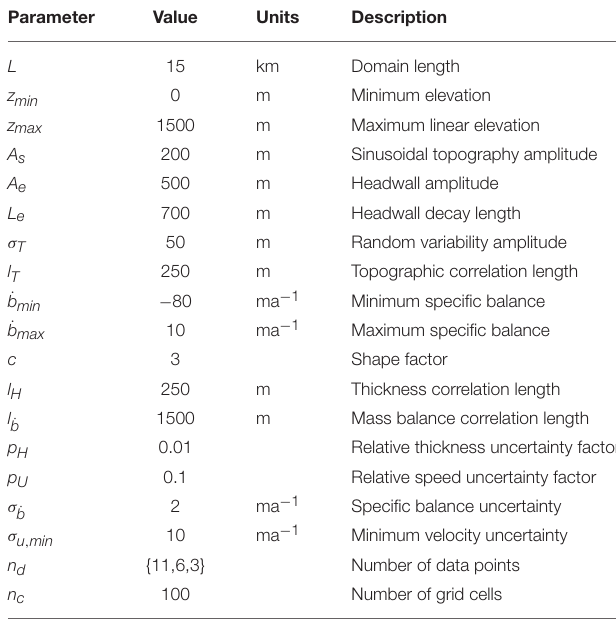
TABLE 1 | Table of relevant constants for the experiment outlined in Sections 3.1 and